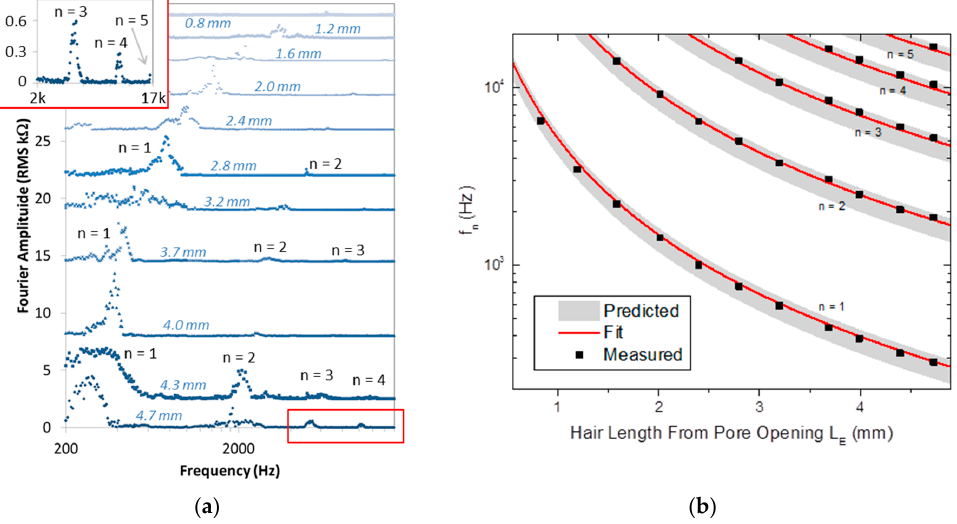
Figure 2. ( a ) The amplitude of the Fourier transformed response of Sensor 2 at the input frequency versus the input frequency for 11 hair lengths. Data sets all have minimums of near-zero RMS kW, but are offset in resistance for clarity. L E is indicated for each to the nearest 0.1 mm. The resonance peaks are labeled with their mode number and progressively shift to higher frequencies as the length is decreased. (inset) The high-frequency portion of the response at an L E of 4.7 mm. ( b ) The resonance frequencies f n versus the exposed length of the hair. The solid red lines correspond to a ρ A of 1.9 × 10 − 7 kg/m and the gray band shows the predicted frequencies for a range of CNT masses.